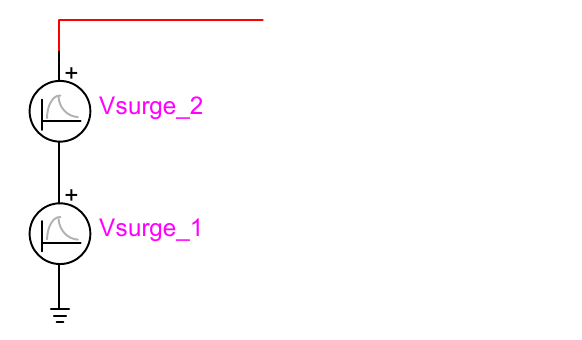
Figure 4. Connecting two voltage surges in series in Electromagnetic Transients Program-Restructured Version (EMTP-RV).